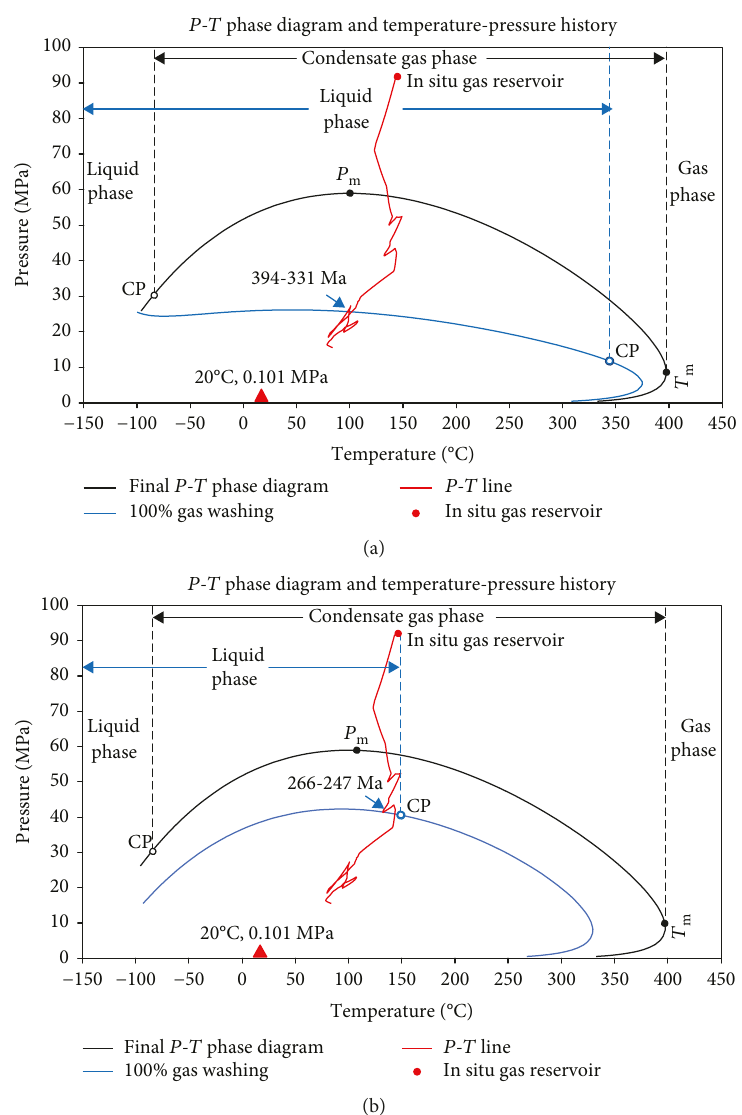
Figure 11: The phase evolution diagram of the fl uid in the Lianglitage Formation (O